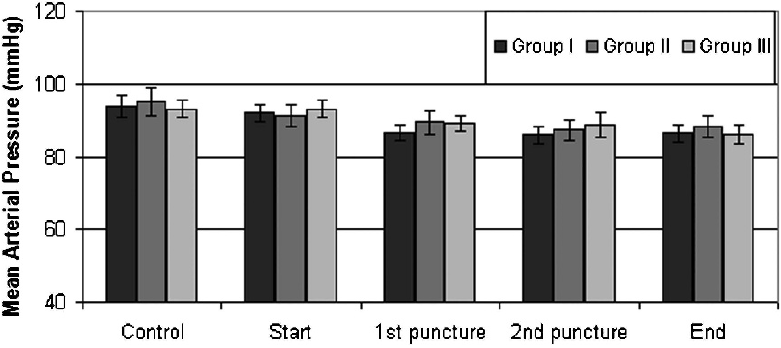
Figure 1 - Mean arterial